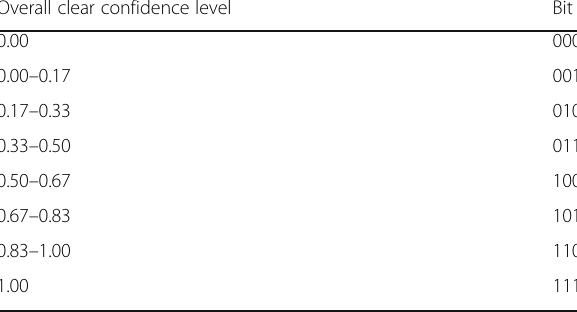
Overall clear confidence